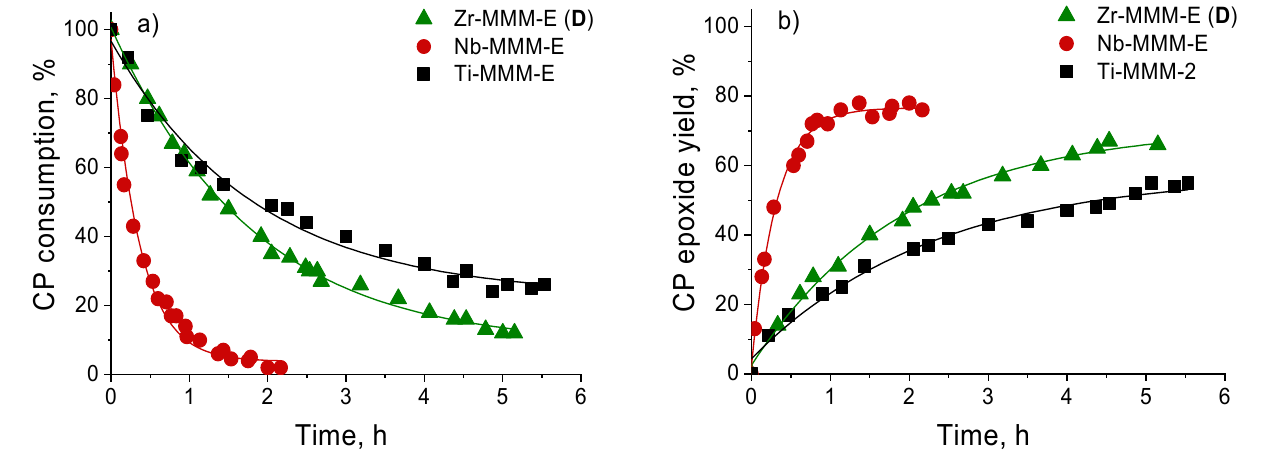
Figure 10. Comparison of catalytic performances of Zr-MMM-E, Nb-MMM-E and Ti-MMM-E in CP epoxidation with H 2 O 2 : kinetic curves for ( a ) CP consumption and ( b ) CP epoxide yield. Reaction conditions: CP 0.1 mmol, H 2 O 2 0.2 mmol, catalyst (0.005 mmol Zr, Nb or Ti), CH 3 CN 1 mL, 50 ◦